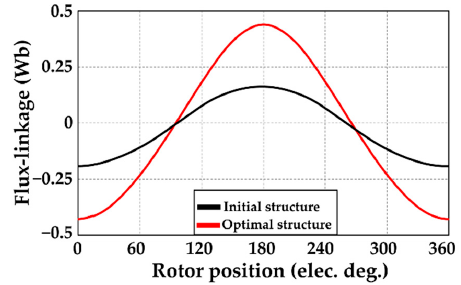
Figure 8. Comparison of flux-linkage.